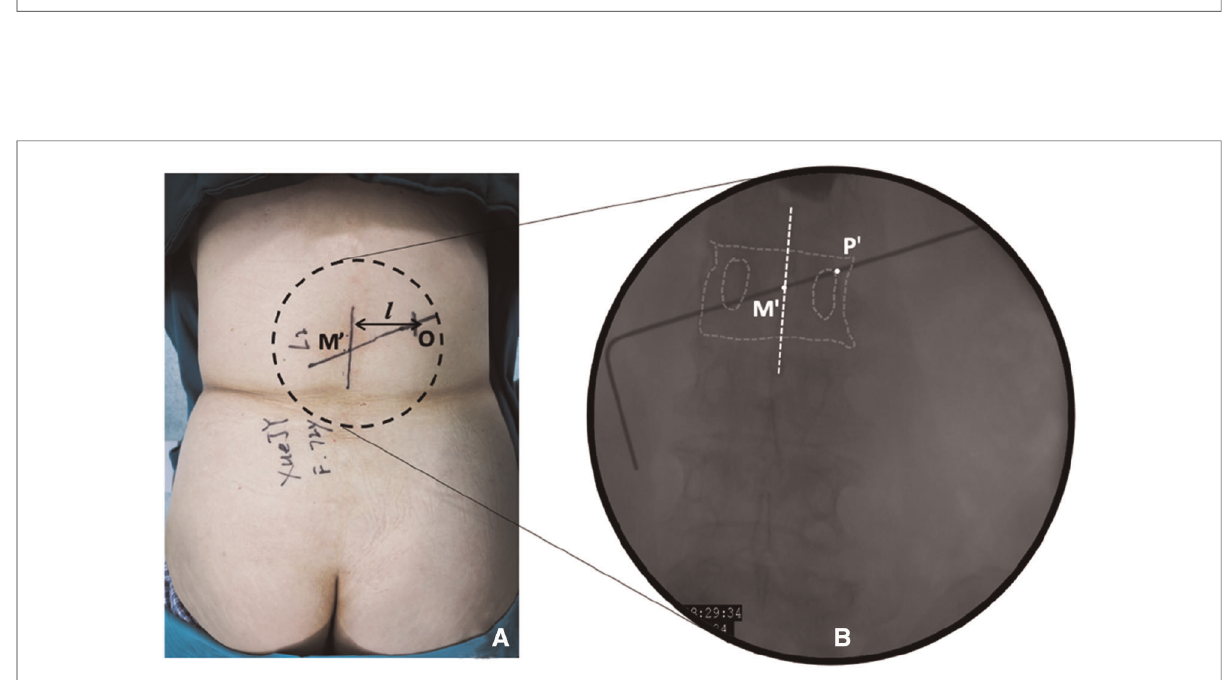
FIGURE 2 Establishment of body surface marker lines in the observation group. ( A ) Setting the dorsal skin marker line. Point M ′ is the projection point of the fi nal puncture target in the skin, and point O is the skin entry point; ( B ) Schematic diagram of the orthogonal vertebral body projection. Point M ′ is the central projection point of the vertebral body, and point P ′ is the bony approach projection